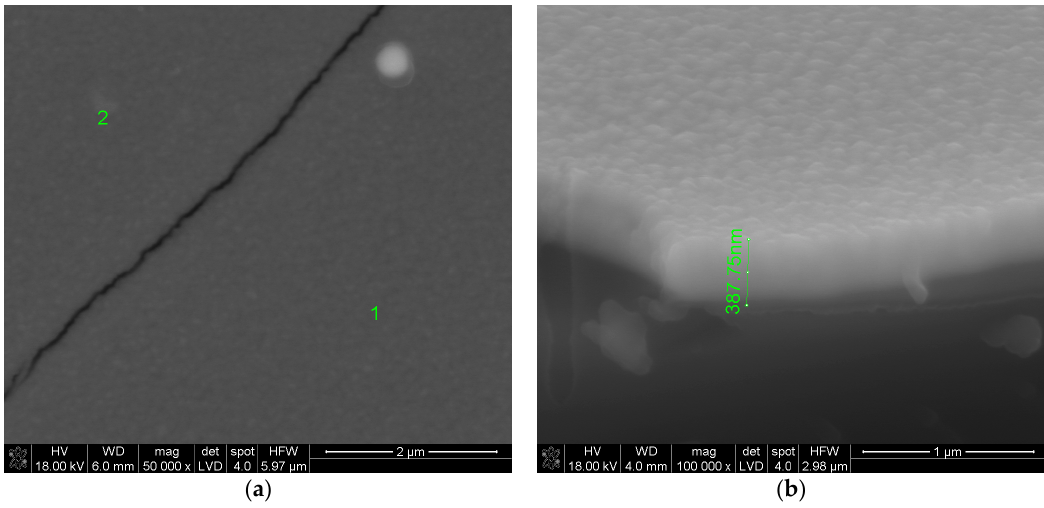
Figure 6. The surface ( a ) and cross-section ( b ) of the layer synthesized at 500 °C. The mass of reactants was 1.5 times greater than in the case of the sample presented in Figure 1. Synthesis time: 30 min. (50% longer than in the case of the sample shown in Figure 1). Other synthesis parameters were the same as in the previous case.